Question: Briefly state, in one sentence, what is plotted here.
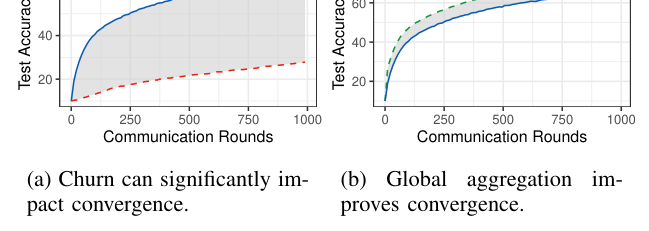
Answer: The effect of churn (left) and the convergence of local and global aggregation (right) in D-PSGD.